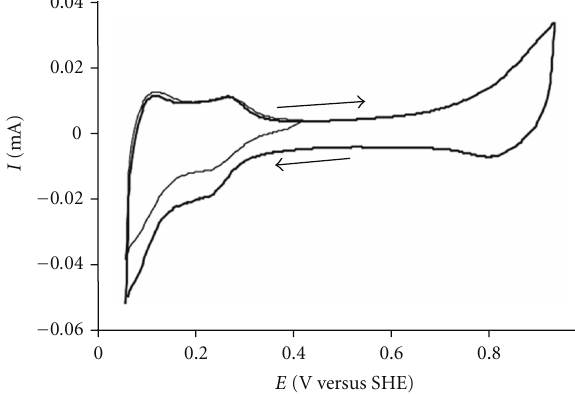
Figure 5: Cyclic voltammograms of electrodeposited Pt particles on BDD electrode. Recorded in a N 2 -saturated 1M HClO 4 solution at 50mVs − 1 and 25 ◦ C. Conditions of electrodeposition: single potential step (5s) from 1 to 0.02 V in a N 2 -saturated 2 mM H 2 PtCl 6 + 1 M HClO 4 solution (reprinted with permission from